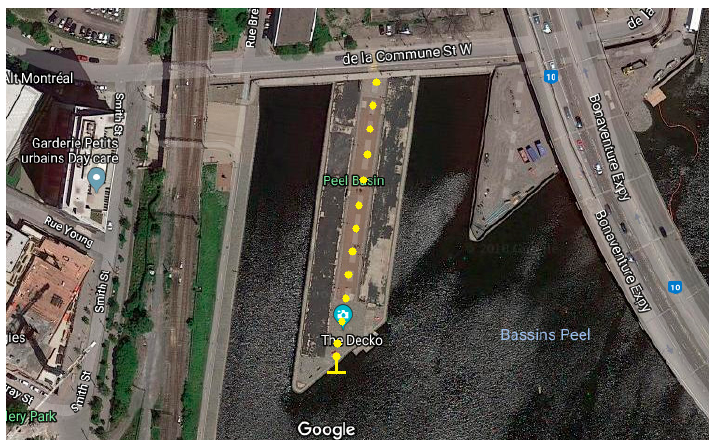
Figure 11. Google satellite image of the field measurement setup in the urban area.